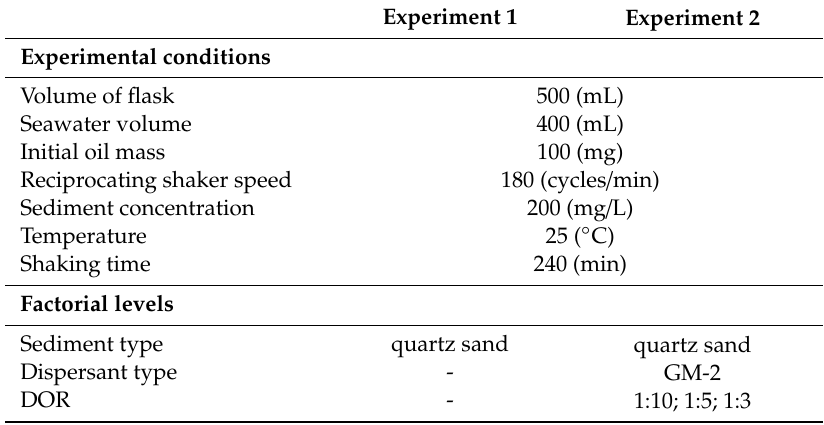
Table 2. Experimental conditions and factorial levels for the laboratory experiments. Experiment